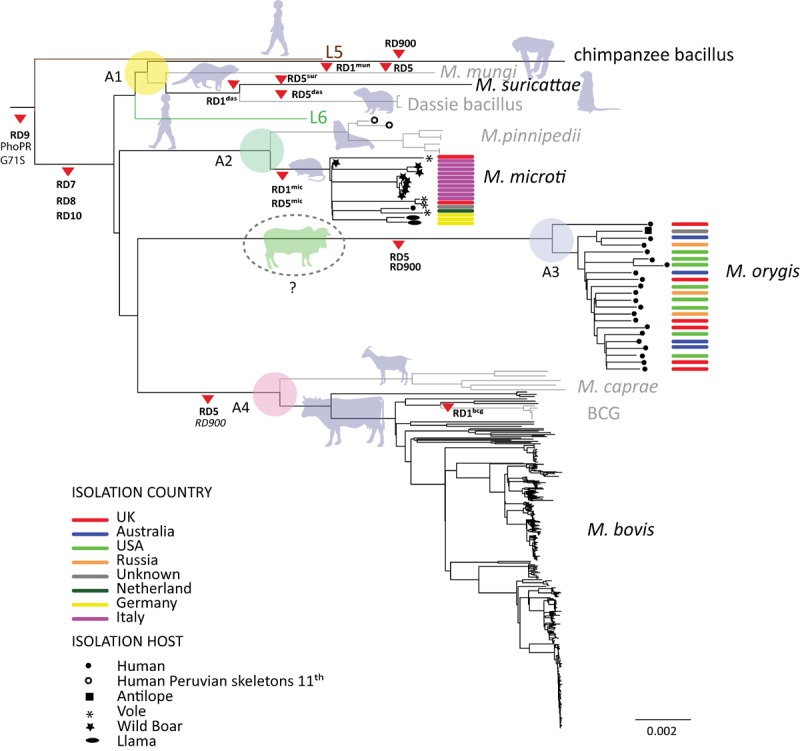
Topology showed in Figure 1 after collapsing all human-adapted branches. Branch lengths are proportional to nucleotide substitutions and the topology is rooted with Mycobacterium canettii. Support values are those of Figure 1. Main large deletions discussed in the text are indicated by red arrow heads and RD specific nomenclatures are indicated when available (Brodin et al., 2002; Mostowy et al., 2004; Alexander et al., 2010; Parsons et al., 2013; Dippenaar et al., 2015). Deletions which are polymorphic in terms of their presence or absence within main clades are indicated in italics.